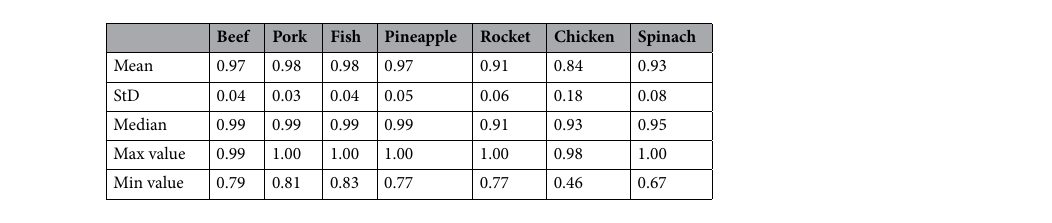
Table 3. Classification probabilities statistics per